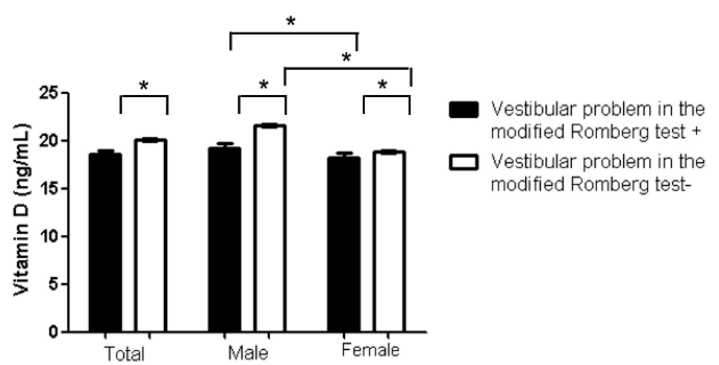
Figure 2. Serum vitamin D levels according to the vestibular problems in the modified Romberg test groups (* p < 0.05).